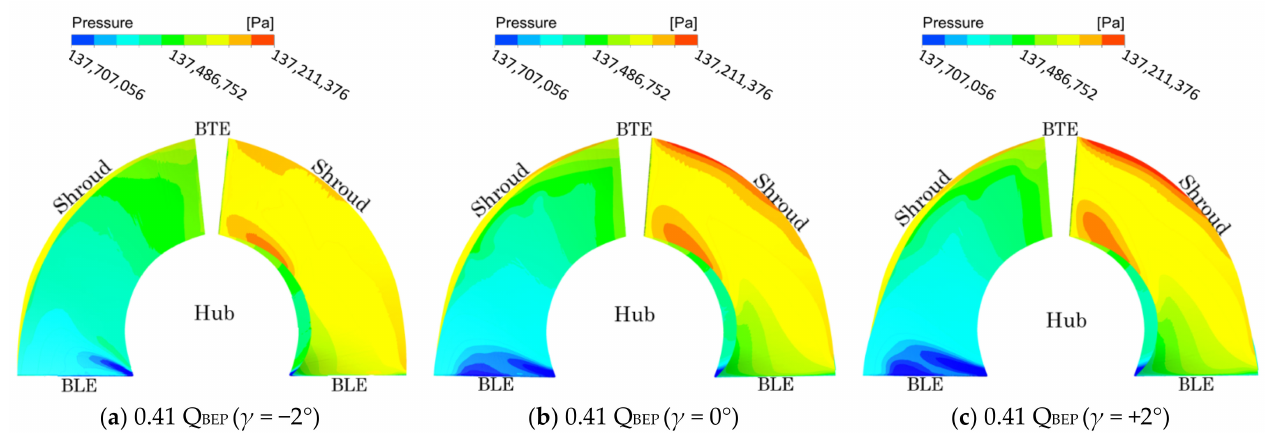
Figure 20. Pressure distribution contours on runner BSS (left side of each figure) and BPS (right side of each figure) under deep part-load conditions (0.41 Q BEP